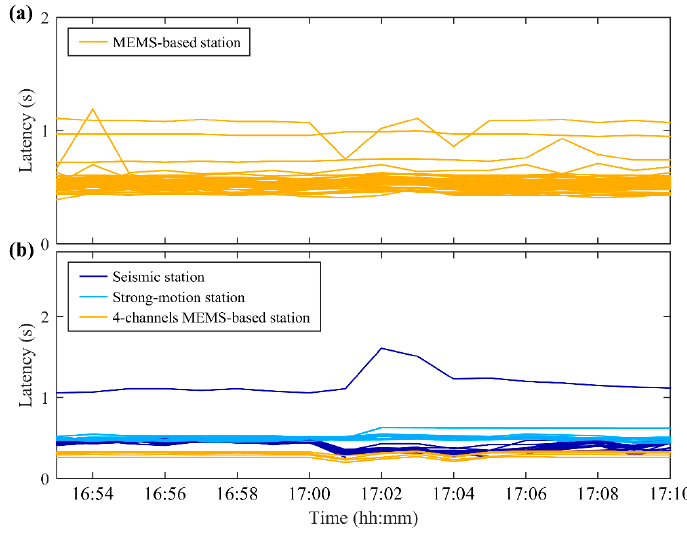
Figure 8. Real-time data latency responses of different station types with data being transmitted by ( a ) FSU links and ( b ) fiber lines to the 2022 M 6.1 Lushan earthquake. ( a ) FSU links and ( b ) fiber lines to the 2022 M 6.1 Lushan